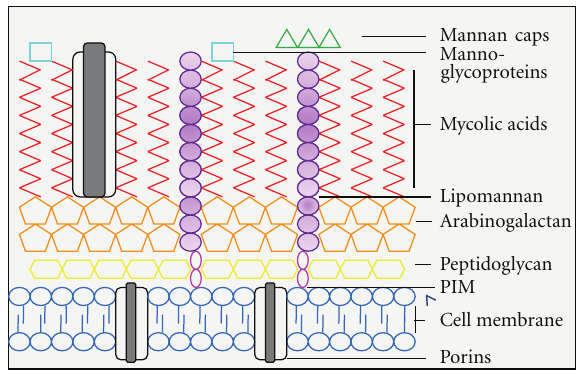
Figure 1: The structure of the Mycobacterium tuberculosis cell wall. This figure shows a schematic representation of the major components of the cell wall and their distributions. The inner layer is composted of peptidoglycan which is covalently linked to arabinogalactan layer. The outer membrane contains mycolic acids, glycolipids like (mannose-capped) lipomannan, and mannoglyco-